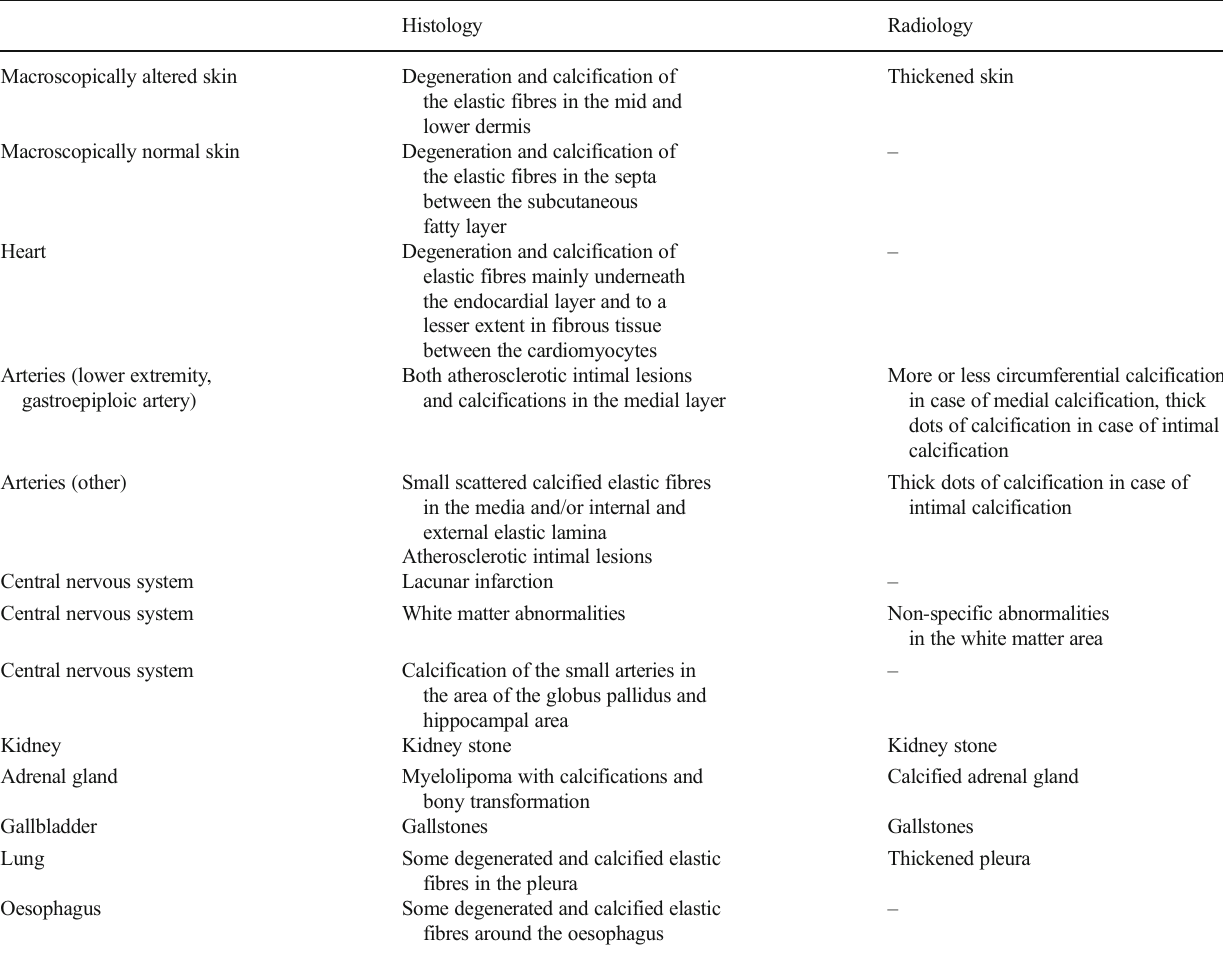
Table 1 Alterations found histologically and radiologically in the two PXE patients